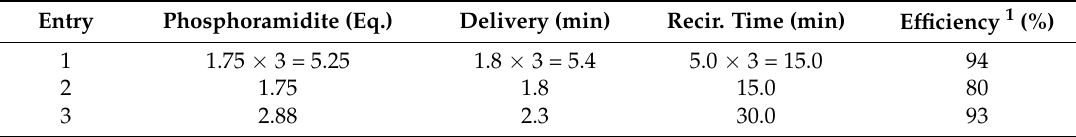
Table 2. Impact of phosphoramidite equivalents on coupling efficiency.